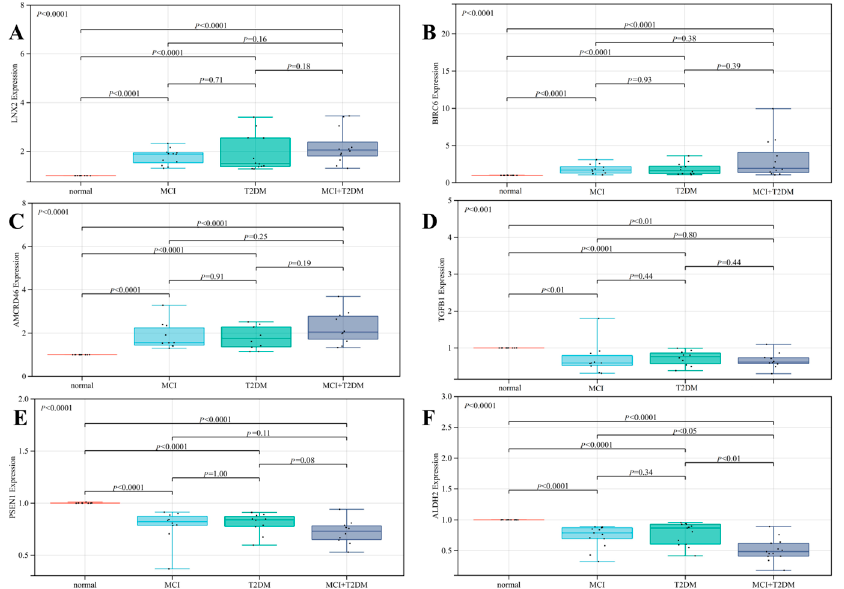
Figure 7. Results of qRT-PCR analysis. ( A ) LNX2; ( B ) BIRC6; ( C ) ANKRD46; ( D ) TGFB1; ( E ) PSEN1; ( F ) ALDH2.